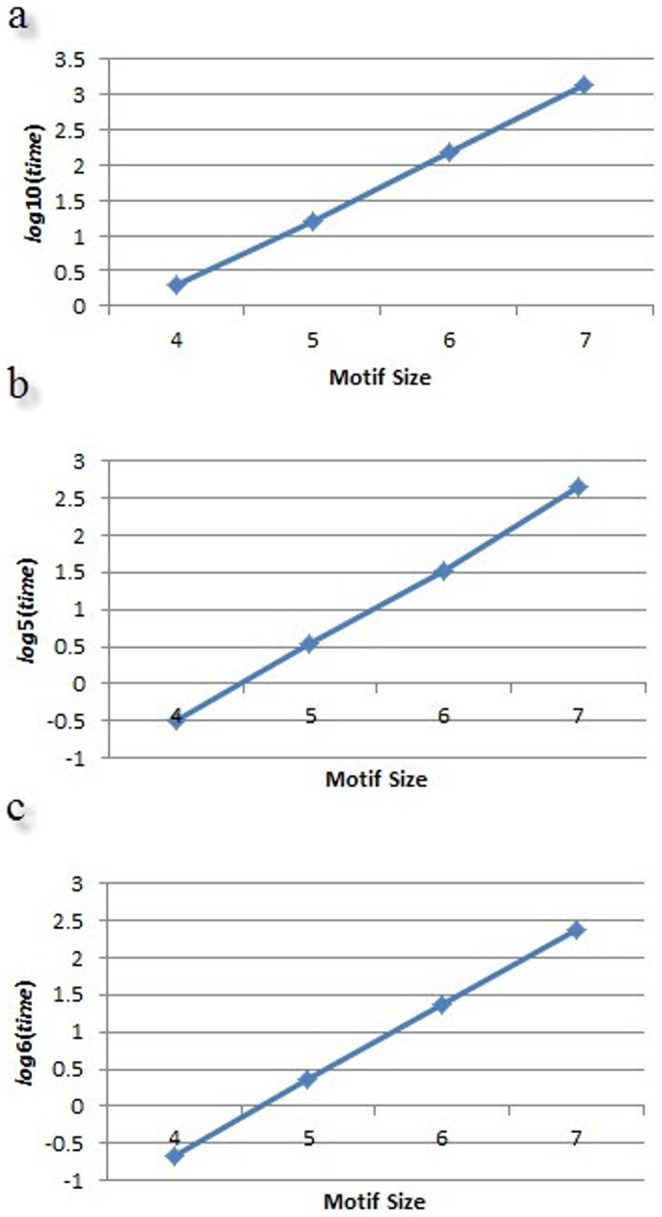
Exponential growth of processing time by motif size.Illustrated results are for (a) transcriptional network of E. coli, (b) Electronic network, and (c) Social network.